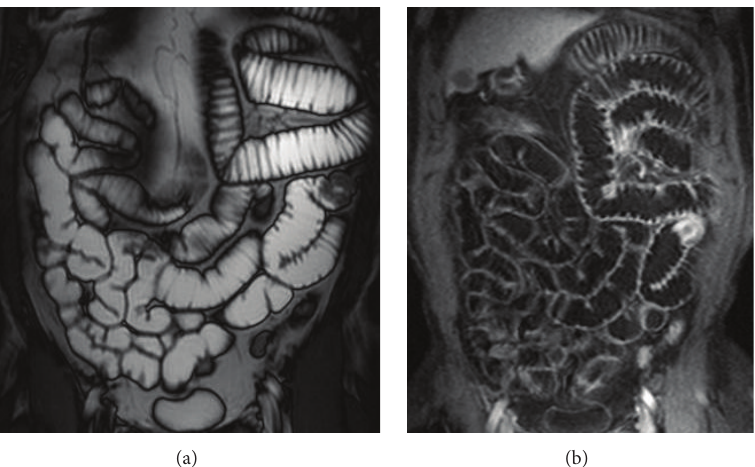
Figure 1: MRI, TrueFISP coronal sequence (a): a circumferential thickening protruding in the intestinal lumen with tendency to invagination is detected, in absence of local infiltration. In the VIBE sequences after the i.v. contrast medium administration (b), there is an inhomogeneous contrast enhancement. Definitive histology: adenocarcinoma.